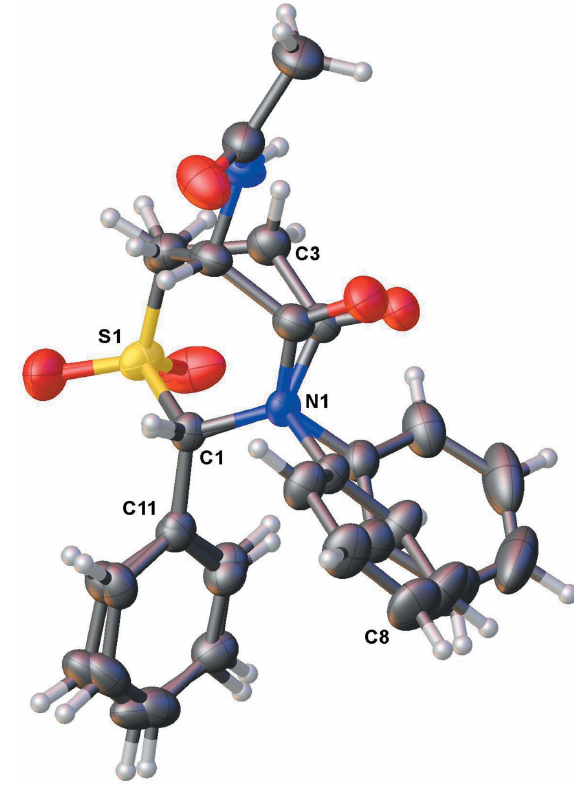
Figure 2 The asymmetric unit of 2 with displacement ellipsoids drawn at 50% probability level.